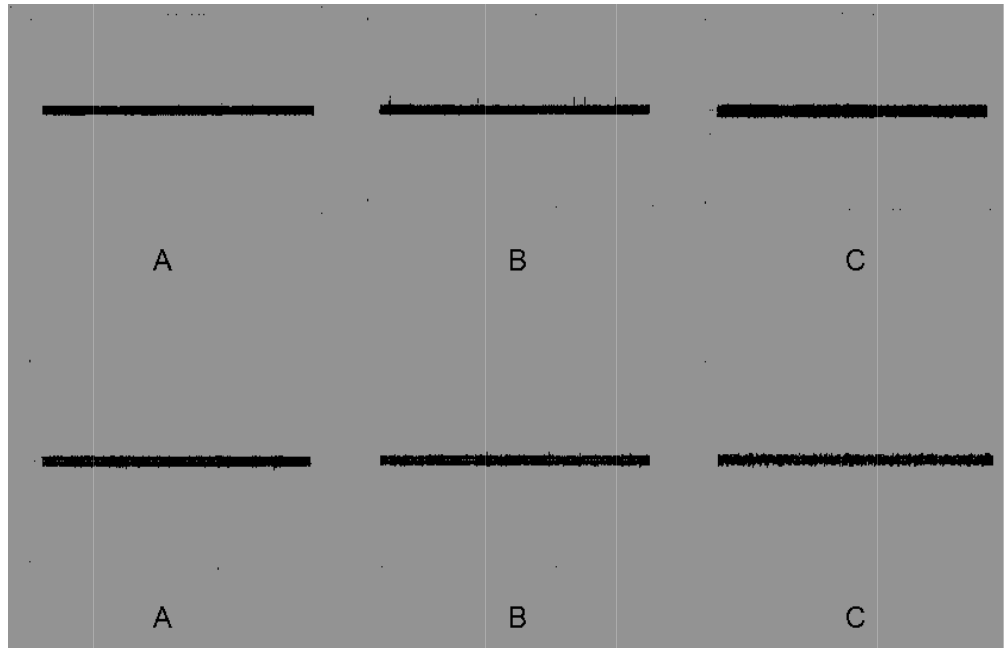
FIGURE 3 - Effect of lidocaine - 20 µg/mL (upper tracing) and racemic bupivacaine - 5.0 µg/mL (lower tracing) in the miniature end-plate potentials (MEPP) in rat phrenic nerve-diaphragm preparation. A: control; B: 30 minutes after the local anesthetic’s addition; C: 60 minutes after the local anesthetic’s